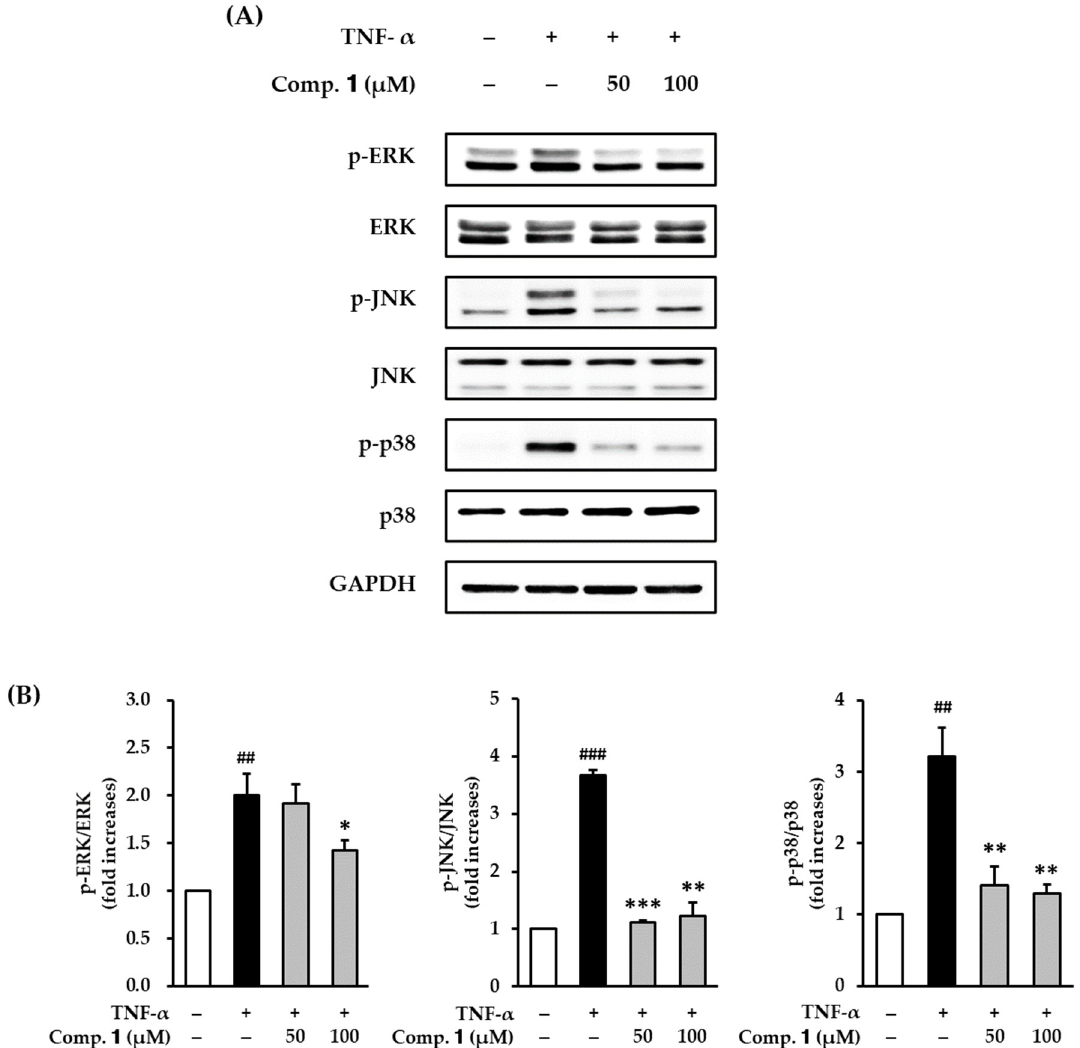
Figure 7. Effects of 1,3-dihydroxy-2,8-dimethoxy-6-methylanthraquinone ( 1 ) on phosphorylation of MAPKs in TNF- α - stimulated HDFs. HDFs were untreated or treated with TNF- α , followed by treatment with 1 for 15 min. Protein expression levels were determined using Western blot analysis. ( A ) Protein expressions of p-ERK, ERK, p-JNK, JNK, p-p38, p38, and GAPDH. ( B ) Relative protein expression levels of p-ERK/ERK, p-JNK/JNK, p-p38/p38, and GAPDH. The data are presented as mean ± SEM from three independent experiments. ## p < 0.01 and ### p < 0.001 difference compared to untreated cells. * p < 0.05, ** p < 0.01, *** p < 0.001 difference compared to TNF- α -stimulated cells.